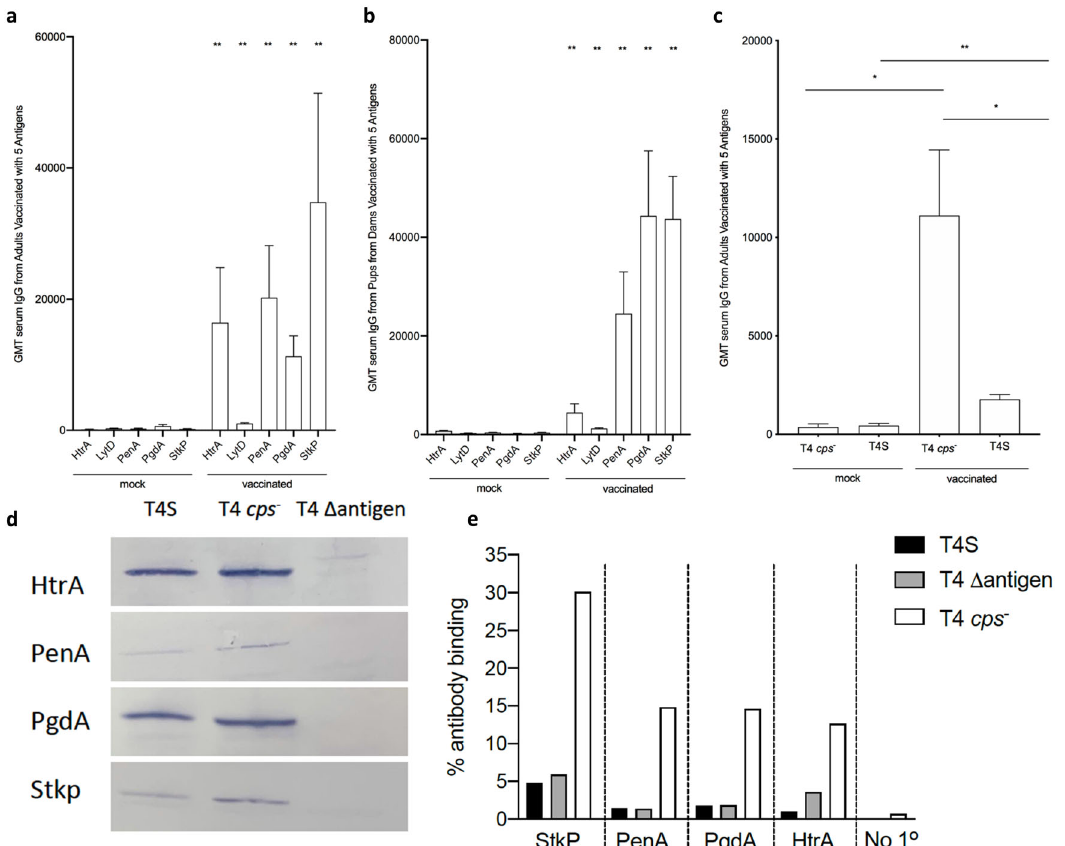
Fig. 3 Effect of immunization on antibody responses. Dams were vaccinated with the fi ve-antigen combination (StkP, PenA, PgdA, HtrA, and LytD) with adjuvant and compared to adjuvant alone controls (mock). Serum from a adults ( n = 6) and b pups from vaccinated dams ( n = 5) was used to quantify serum IgG responses to individual antigens by ELISA. Statistical signi fi cance of ELISA values was determined using a Mann – Whitney test. c Adult sera were also used in a whole bacterial cell ELISA using the unencapsulated mutant (T4 cps – ) or its encapsulated parent strain (T4S). Values represent geometric mean titers ± S.E.M. ELISA values were compared using an unpaired Student ’ s t test. * P < 0.05, ** P < 0.01. d P ooled sera ( n = 5) from adult mice immunized with the individual antigen shown was used in Western analysis on whole-cell lysates of strain T4S, the unencapsulated mutant T4 cps − or the mutant construct corresponding to the sera tested. e Representative fl ow cytometric comparison of antibody binding to the surface of strain T4S, the unencapsulated mutant T4 cps − ) or the mutant construct corresponding to the sera tested. Samples tested were pooled sera ( n = 5) from adult mice immunized with the individual antigen shown below or a no sera